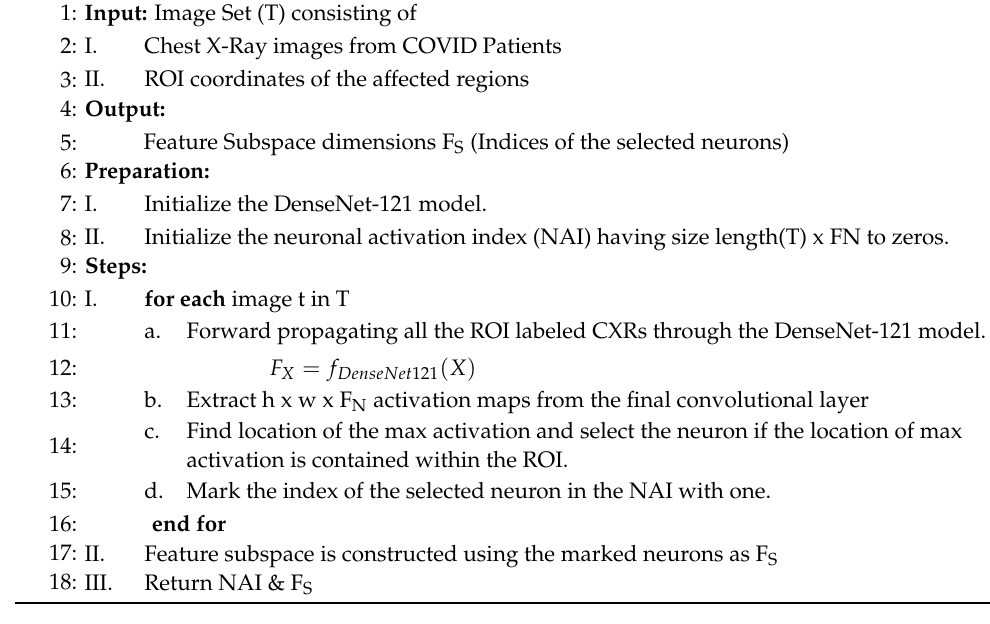
Algorithm 1: COVID-Specific Deep Feature Space Construction